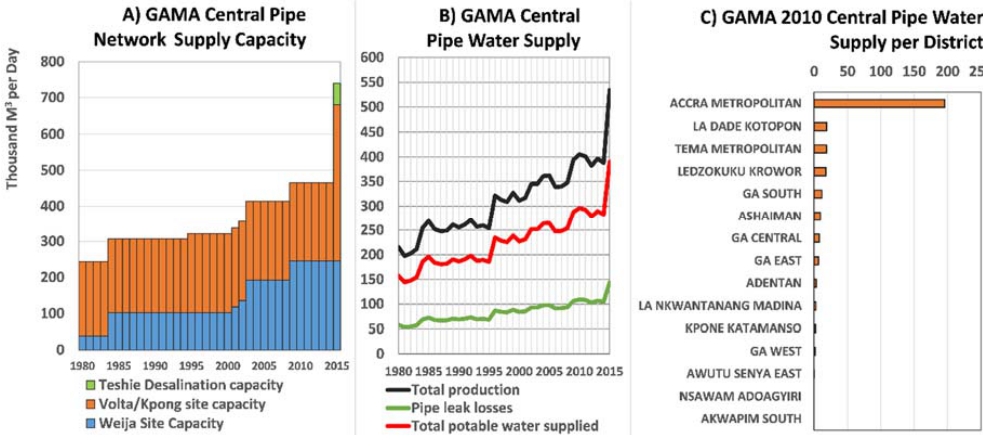
Figure 6. Centrally supplied water in GAMA. ( A ) Total central water treatment capacity in GAMA in m 3 from 1980 to 2015. ( B ) Total water produced, lost from leaks, and supplied to customers. ( C ) Estimated distribution of water supplied per district for 2010.